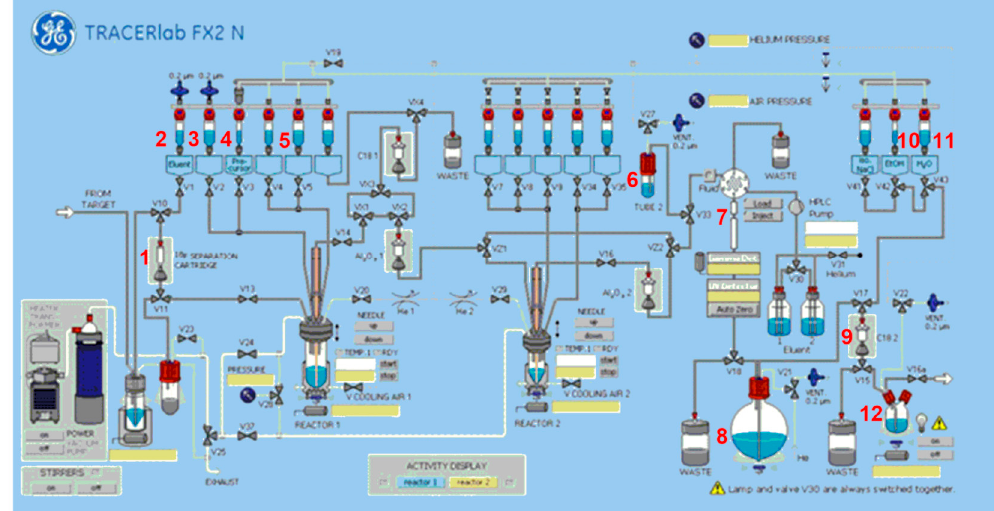
Figure 7. Scheme of the synthesis module TRACERlab FX2 N for the radiosynthesis of [ 18 F] BIT1 . (1)